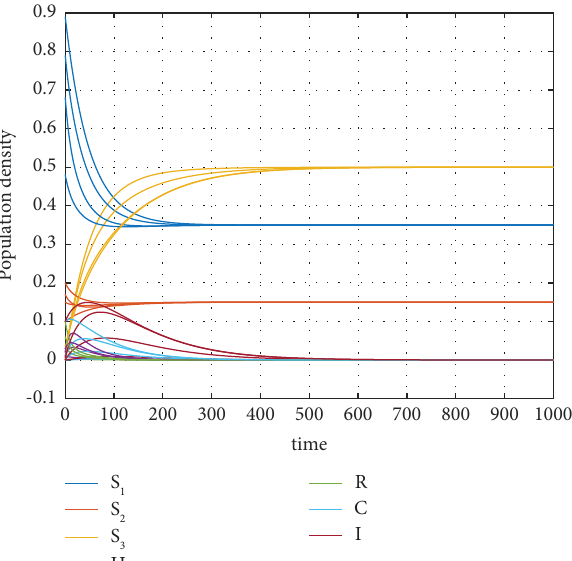
Figure 6: Evaluation of model (1), R